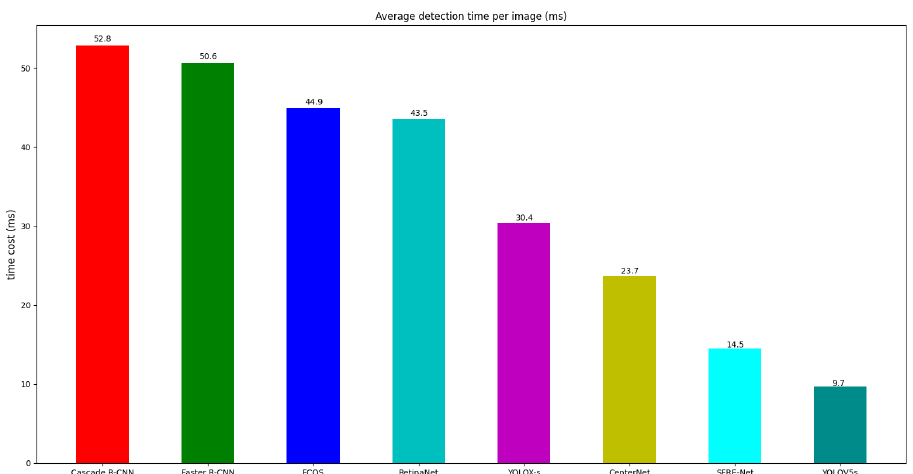
Figure 11. Average inference time per image for different algorithms.